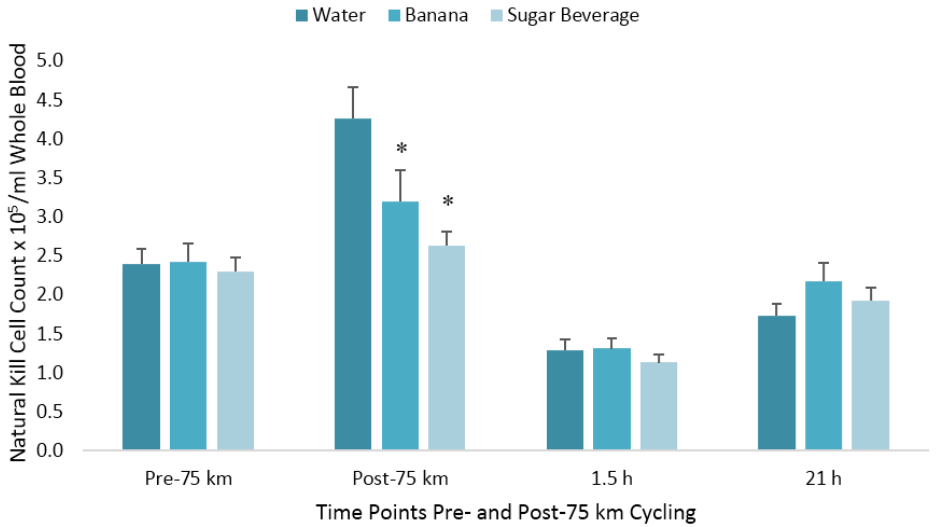
Figure 2. Changes in natural killer cell counts per milliliter of whole blood following 75 km cycling in n = 20 cyclists (immediately, 1.5 h, and 21 h post-exercise). * p ≤ 0.017 compared to the change from pre-exercise in the water condition. Vertical lines represent the standard errors. Time effect, p < 0.001; time × trial effect, p < 0.001.